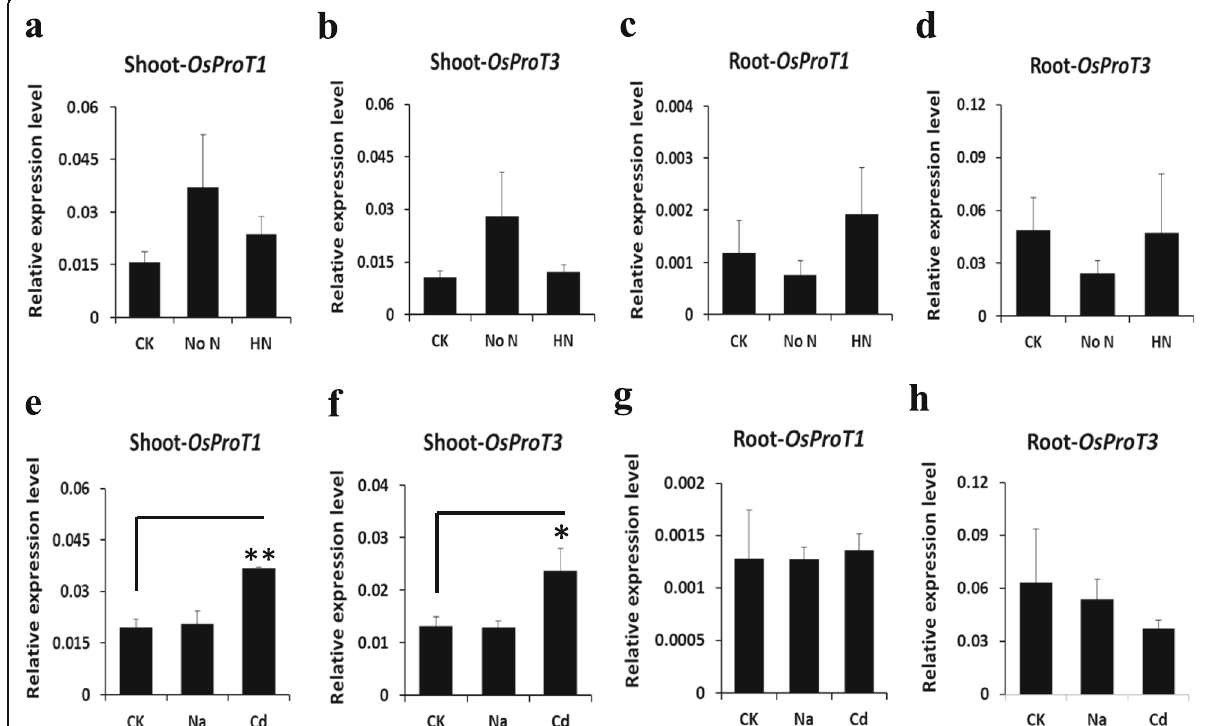
Fig. 7 Expression levels of OsProTs in response to different abiotic stresses. a - d , OsProT1 ( a, c ) and OsProT3 ( b, d ) transcript levels in response to nitrogen deficiency or high nitrogen treatment. e - h , Expression levels of OsProT1 ( e, g ) and OsProT3 ( f, h ) in response to salt stress or cadmium treatment. Rice plants were grown hydroponically for about 2 weeks using Yashida solution, and then exposed to Yoshida solution (CK) or Yoshida solution without NH 4 NO 3 (No N), with 10 mM NH 4 NO 3 (HN), with 50 μ M CdCl 2 (Cd) or with 100 mM NaCl (Na) for 2 days. Roots and shoots were harvested for RNA extraction and detection of OsProTs expression level. Values are means ± SD, n = 3. Statistical significance was tested by two-tailed Student ’ s t tests. Differences were dseemed significant at P < 0.05 (*) and extremely significant at P < 0.01